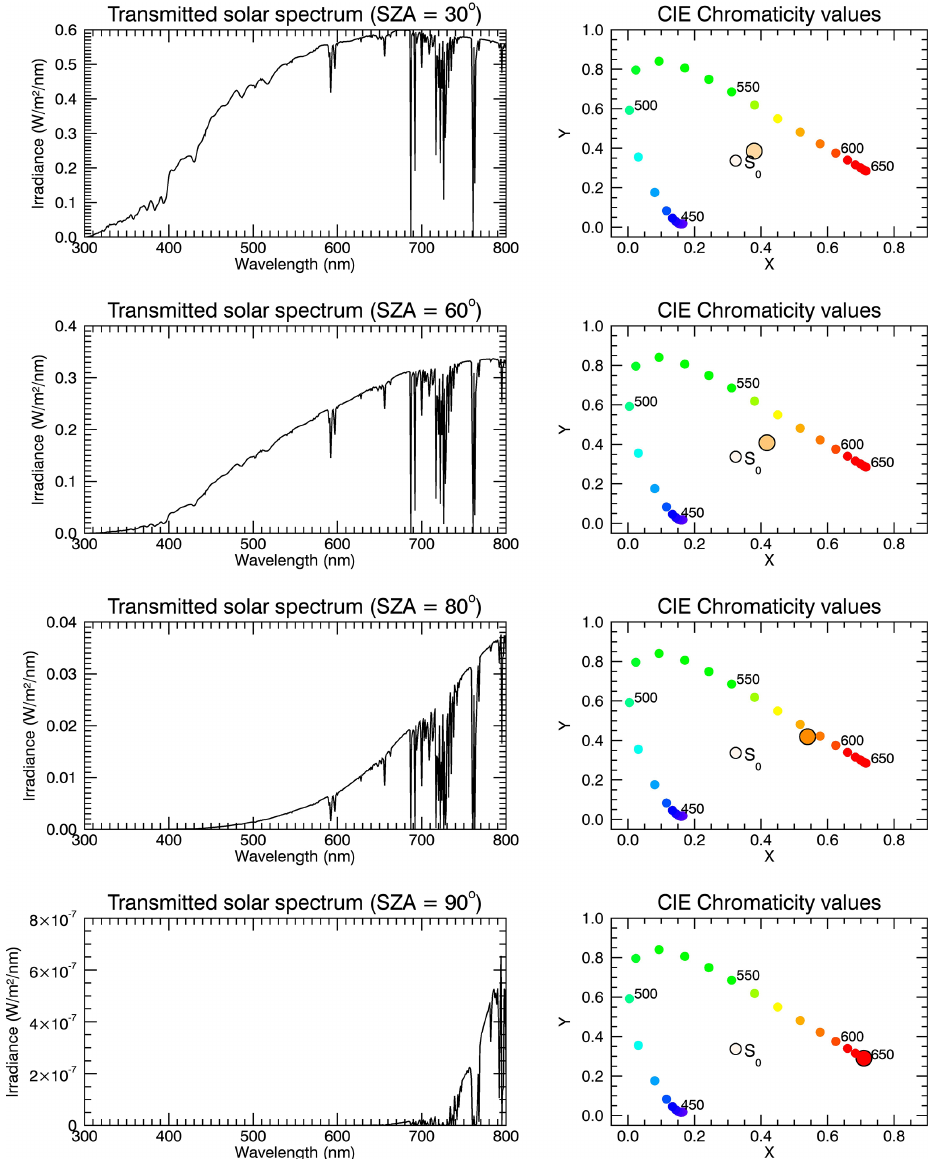
Figure 10. Similar to Fig. 4 but with aerosol absorption with an absorption aerosol optical depth of 1.0 at 550nm and an Ångström exponent of α = 1 . 45, as measured during the SAFARI 2000 campaign (Bergstrom et al.,